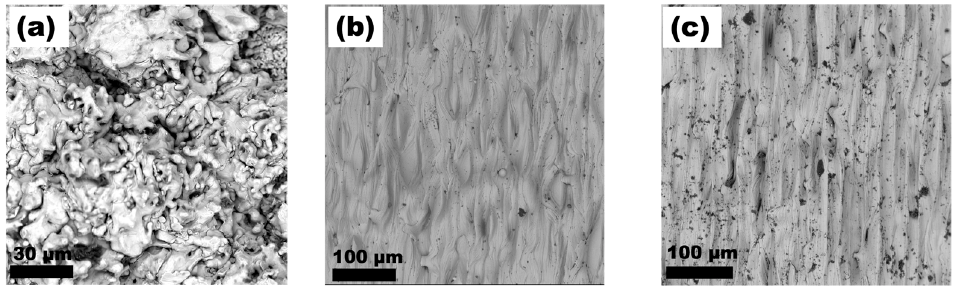
Figure 7. SEM images of surface morphologies ( a ) Ti64-0, ( b ) Ti64-3, ( c ) Ti64-2.